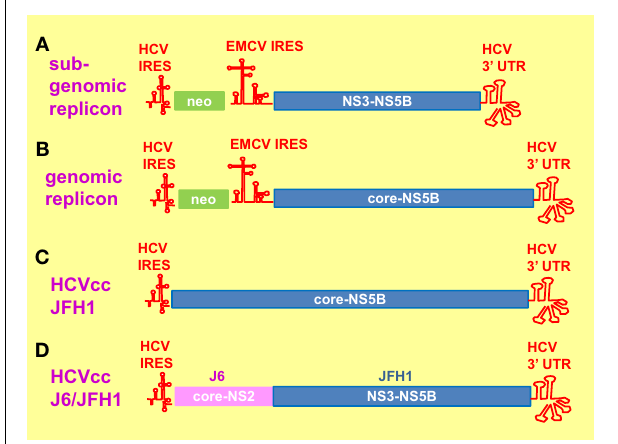
FIGURE 2 | Hepatitis C virus replication systems. (A) Sub-genomic replicon (SGR) consists of a bicistronic mRNA. The 5 (cid:2) neomycin (neo) mRNA is translated by the hepatitis C virus (HCV) internal ribosome entry site (IRES) element whereas the 3 (cid:2) mRNA encoding HCV NS3-NS5B plus the 3 (cid:2) untranslated region (UTR) is translated by the encephalomyocarditis virus (EMCV) IRES element. Cell lines harboring the SGR were established by neomycin selection. (B) The genomic replicon is similar to that of SGR, apart from that the 3 (cid:2) mRNA encodes core-NS5B plus 3 (cid:2) UTR. (C) The HCV cell-cultured infectious system (HCVcc) consists of the entire genomic RNA from JFH1. (D) The chimeric J6/JFH1 is created by fusing the core-NS2 from J6 to NS3-NS5B plus 3 (cid:2) UTR from